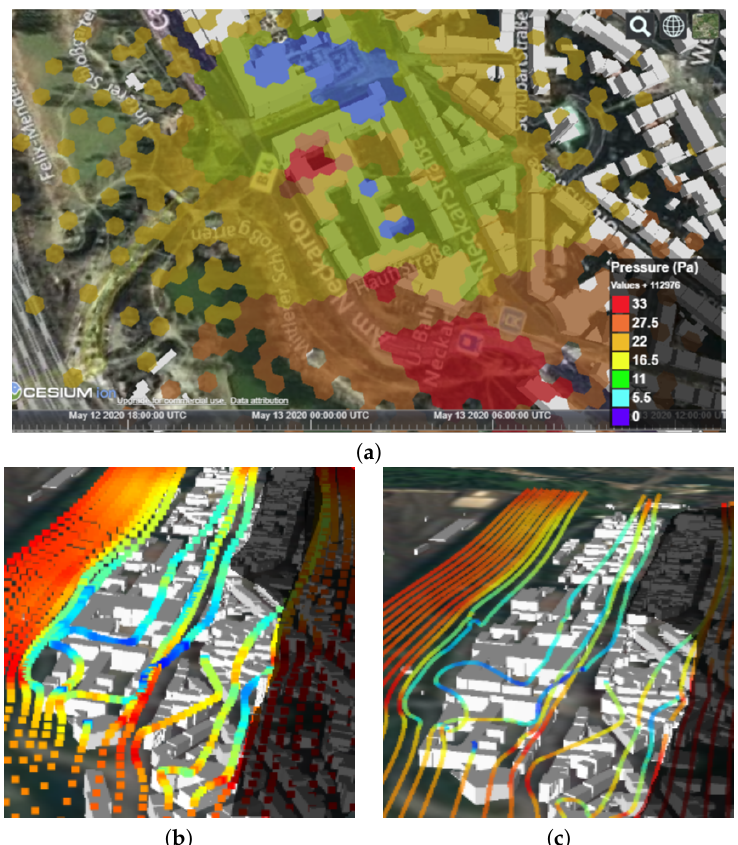
Figure 9. ( a ) A hex-grid displaying hexagonal cells that average the pressure (in units of Pa) for a slice at roof top height. The bottom images show streamline visualizations colored by wind speed (0.5 m/s (blue) up to 3.5 m/s (red)) using ( b ) points and ( c ) Cesium polyline objects. Please note that the darkened area on the right of ( b , c ) were not present in the CFD simulations. This is the reason for the high wind speeds in this area even though there are buildings